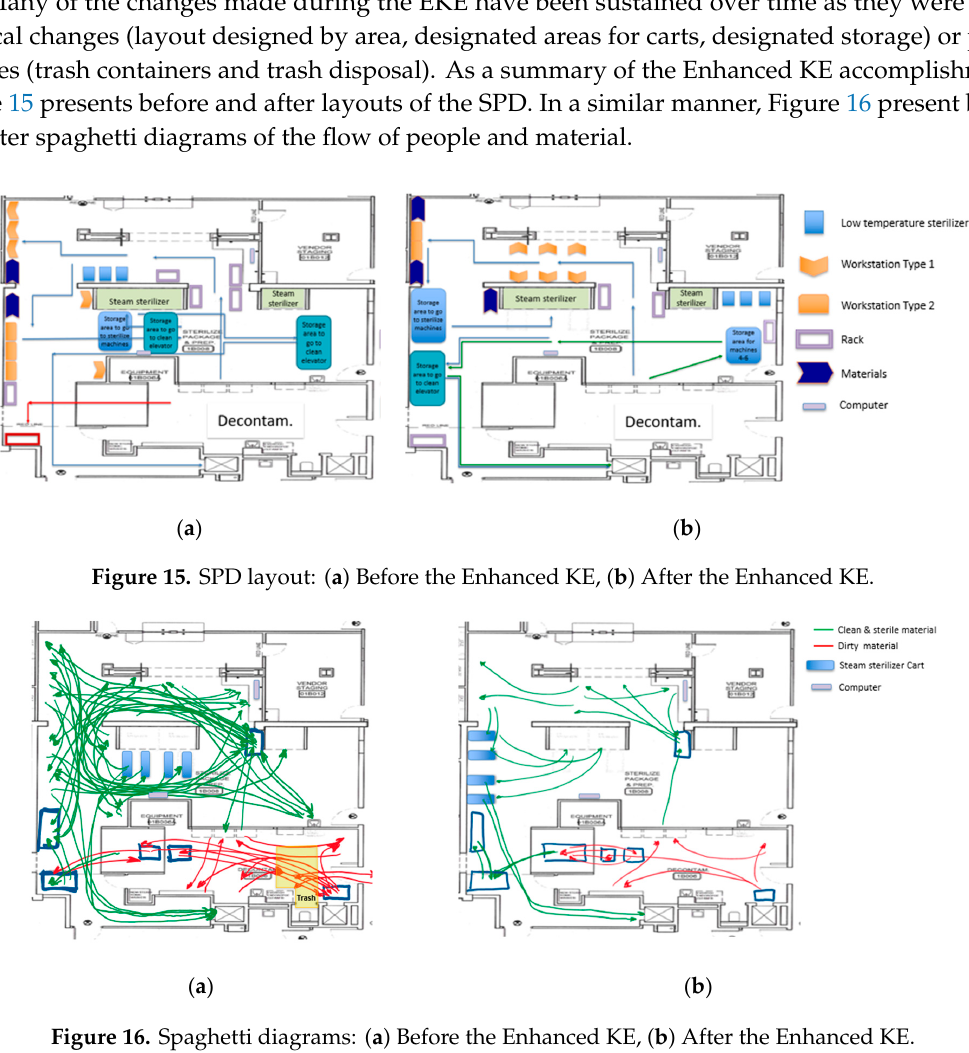
Figure 16. Spaghetti diagrams: ( a ) Before the Enhanced KE, ( b ) After the Enhanced KE.